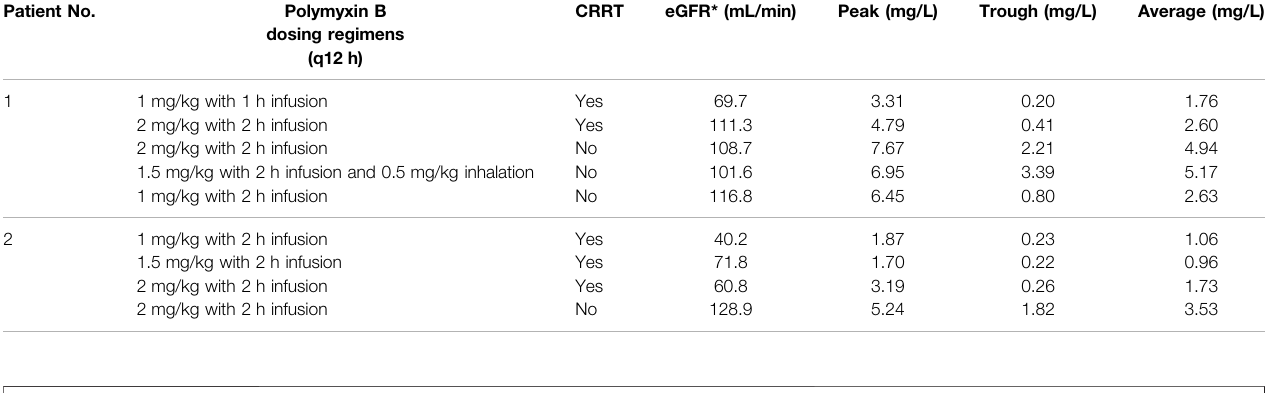
TABLE 1 | Concentrations at different dosing regimens. Patient No.